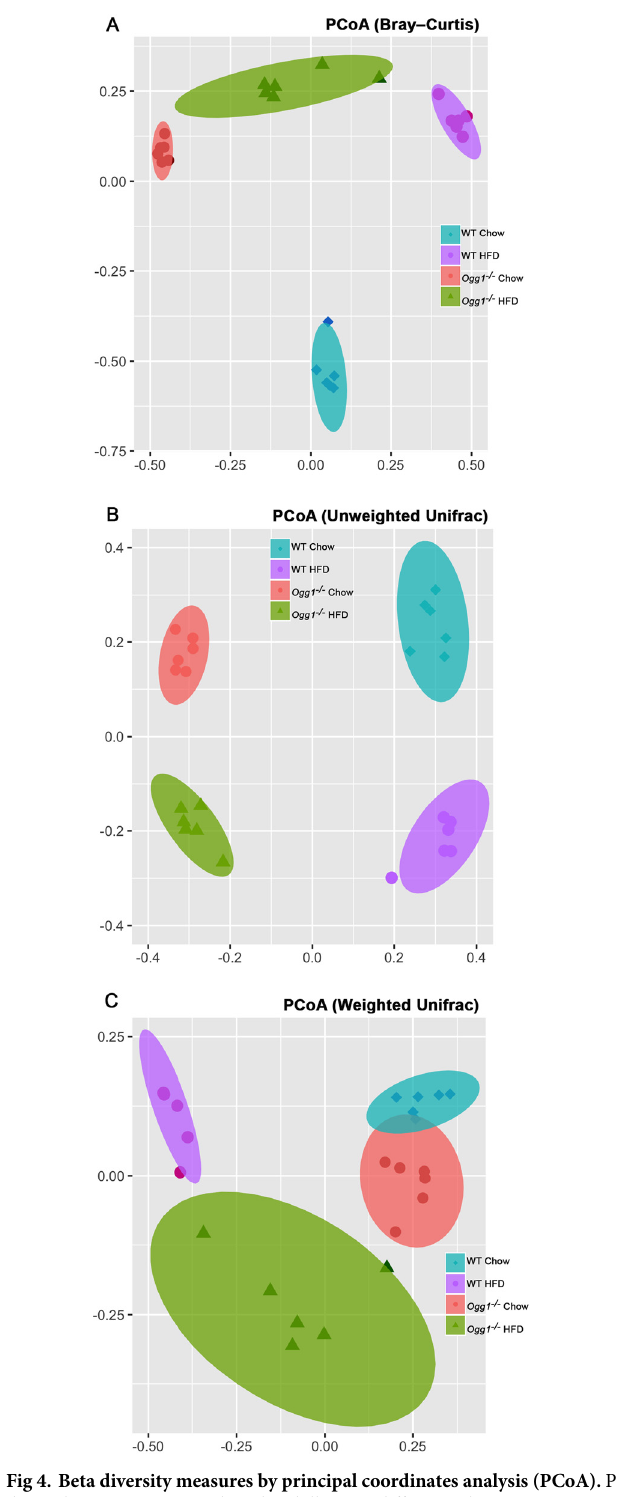
Fig 4. Beta diversity measures by principal coordinates analysis (PCoA). PCoA of the first 2 coordinates of the dissimilarity matrices are plotted and illustrate differences between groups, using (A) the Bray-Curtis dissimilarity matrices at an even depth of 1460 sequences; and (B) Unweighted and (C) weighted UniFrac distances using UPGMA at an even depth of 1460 sequences. 95% confidence intervals are shown by the shaded ellipses. Results are from the analysis of microbial sequences recovered from the fecal samples as described in